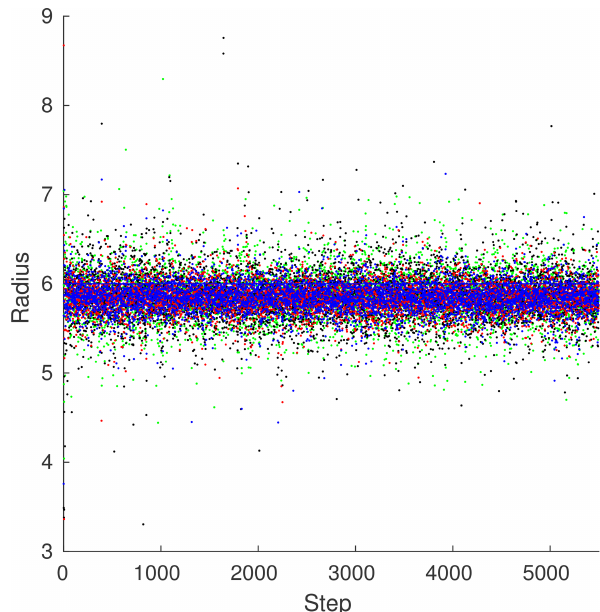
Figure 6. ML96 sample radii. Radii for the configuration in Fig. 5 with α = 1 . 02, ¯ υ = 6, and Var (υ) = 1. Each unique marker type represents a unique radius grouping with a red · representing the first group, a green · representing the second, a blue · representing the third, and a black · representing the fourth. Groups 2 and 4 con- tain variables that were observed fully, and groups 1 and 3 contain variables that were observed partially. The graph has been truncated to only show radii from 3 to 9 in order to better capture the general